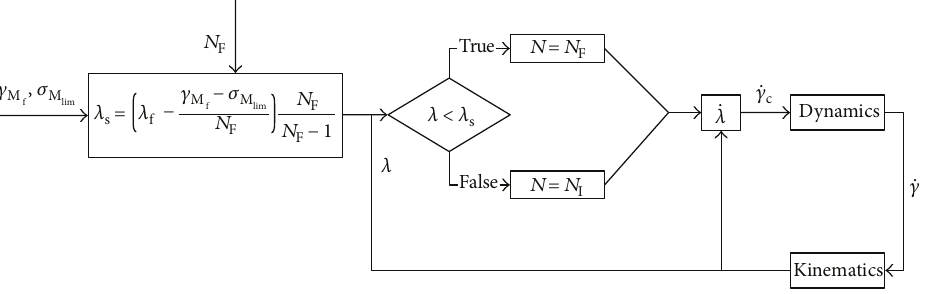
Figure 3: Switching logic of the Table 1: Summary of the parameters and criterions.